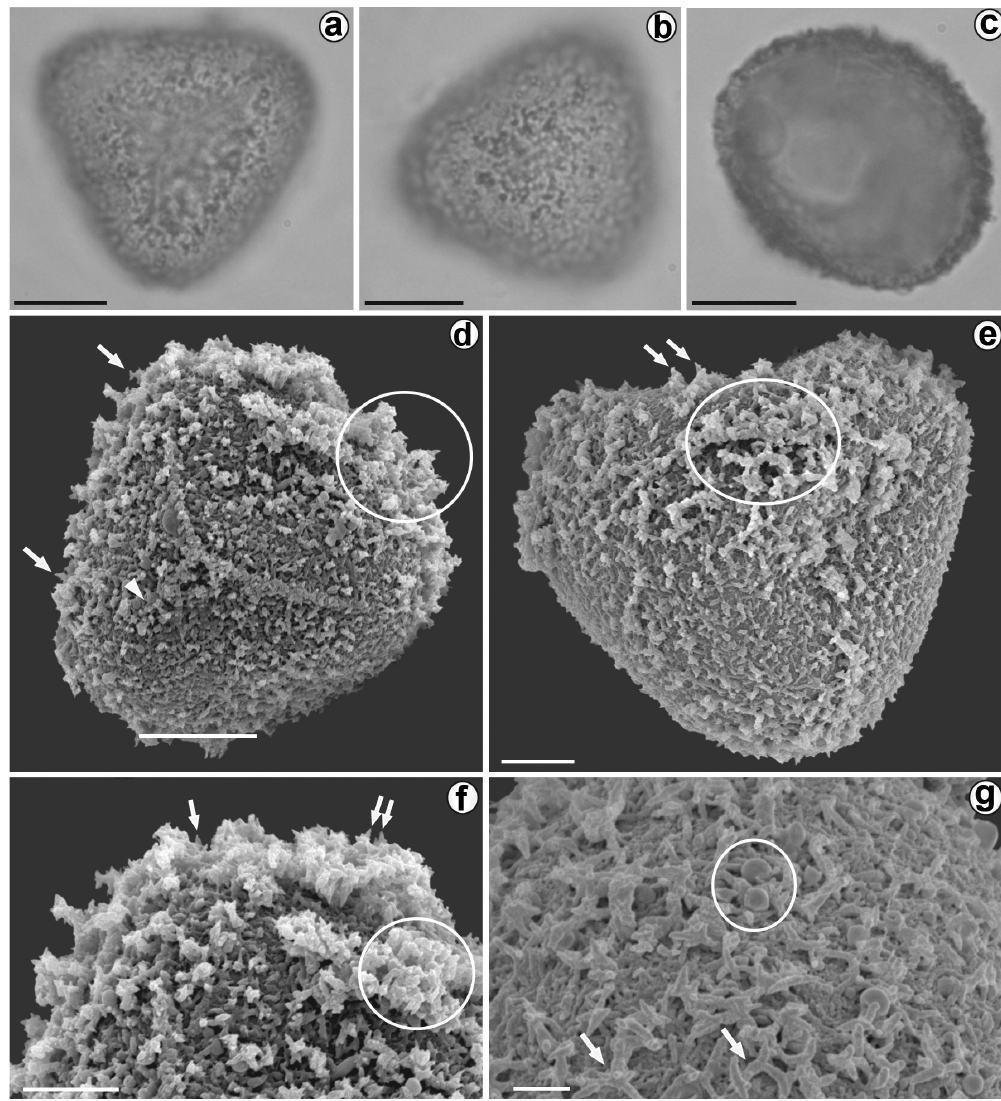
Figure 2 - Spores of Pteridium arachnoideum with LM ( a-c ) and SEM ( d-g ). a. Spore in proximal view. Scale bar = 10 μ m. b. Spore in distal view. Scale bar = 10 μ m. c. Spore in equatorial view. Scale bar = 10 μ m. d. Spore in proximal view. Short threads with spinulate tips (arrow) are fused to form agglomerations (circle). The ornamentation covers the laesura (arrowhead). Scale bar = 10 μ m. e. Spore in distal view. The threads (arrows) are distributed at random on the spore surface and areas with big agglomerations of them are observed (circle). Scale bar = 5 μ m. f. Surface detail in proximal view. Fused threads (arrow) form agglomerations (circle). Scale bar = 5 μ m. g. Detail of the surface in distal view. The threads are rami fi ed and fused to form a massive network (arrow). Dispersed spheroids are observed (circle) Scale bar = 2 μ